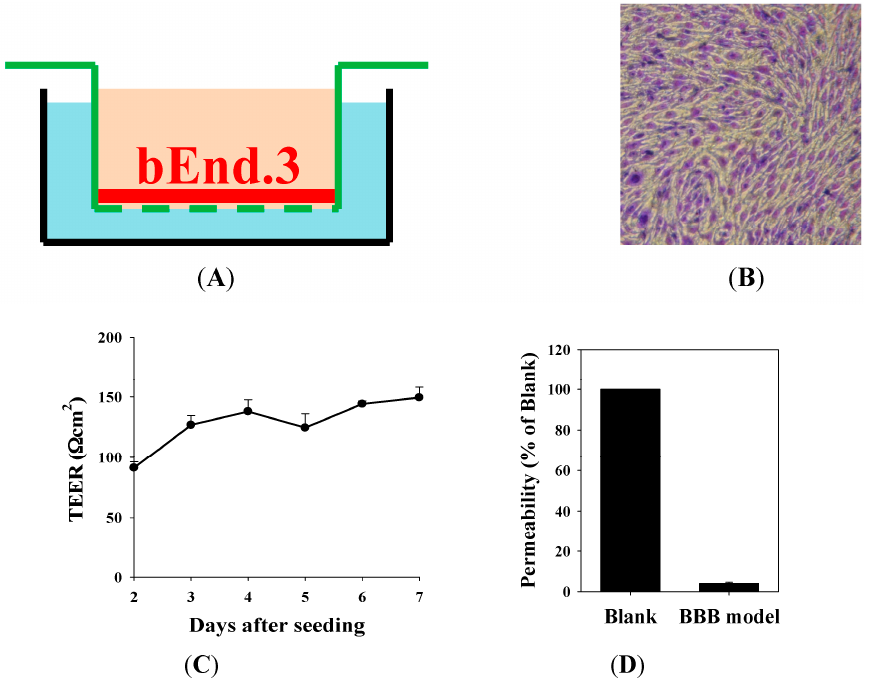
Figure 3. Establishment and barrier integrity of in vitro blood–brain barrier (BBB) model by growing bEnd.3 monolayer on transwell inserts. ( A ) Schematic of the in vitro BBB model; ( B ) Morphology of the BBB model stained with crystal violet. Representative images of intact cell monolayer were captured under a light microscope (magnification, 100×); ( C ) The TEER values were evaluated for seven days after seeding; ( D ) Permeability of fluorescein isothiocyanate (FITC)-dextran across the BBB model at Day 7. Values are the mean ± S.E.M. ( n = 3).